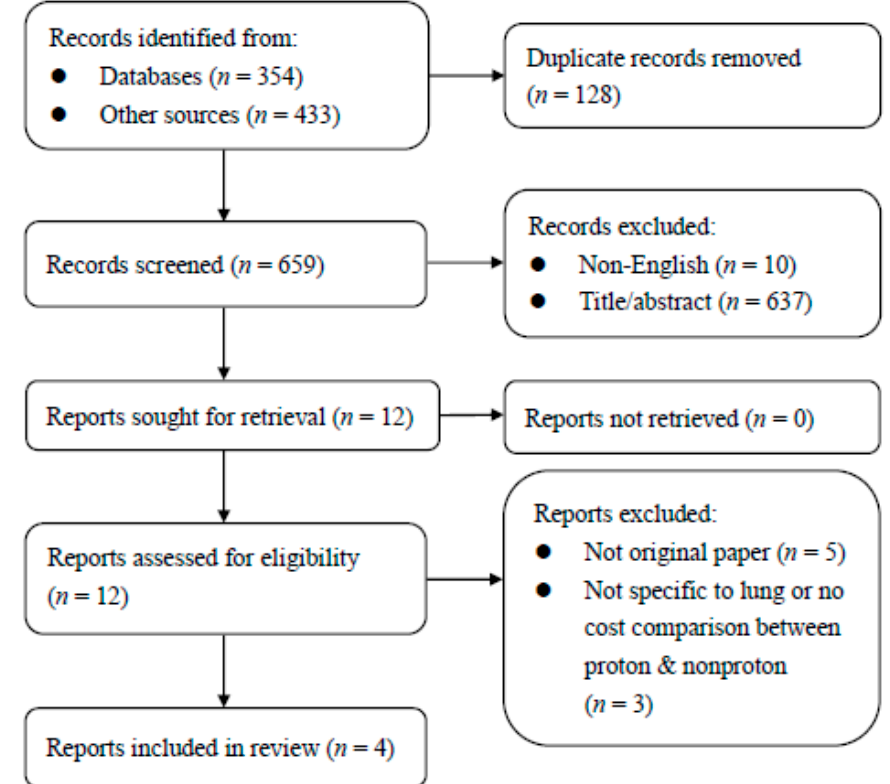
Figure 2. Flow diagram of the literature search.